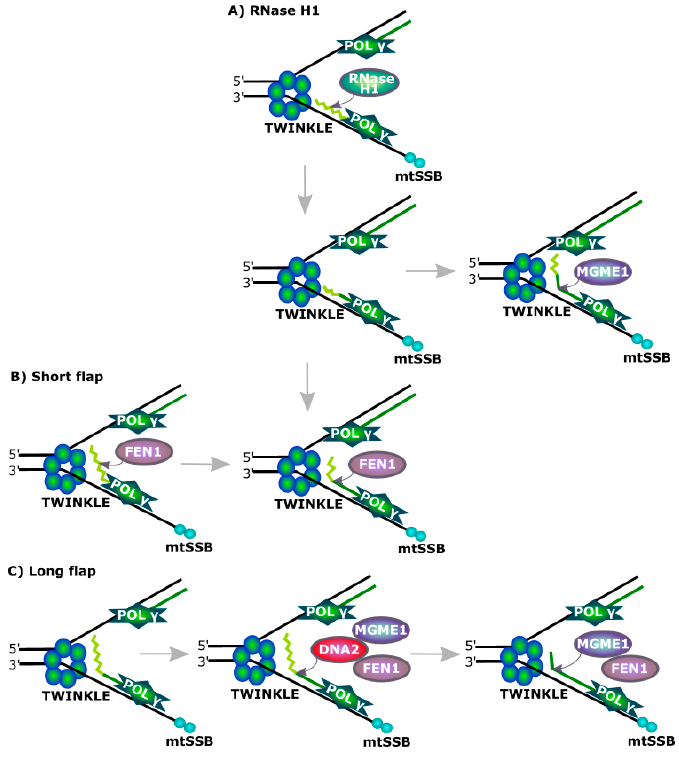
Figure 4. Primer removal during mitochondrial DNA replication. Progress of replication fork is mediated by a DNA topoisomerase (not presented here) separating intertwined mtDNA and the TWINKLE helicase. RNase H1 can degrade most of an RNA primer, but it is not able to remove its last ribonucleotide. When this fragment is reached by Pol γ , it is displaced as a short flap, which can be degraded by FEN1 or MGME1 (mitochondrial genome maintenance exonuclease 1). FEN1 can cleave away entire RNA primer, when it forms a flap and is not too long, but during replication of a heavy strand of mtDNA, primers are much longer than those of its light counterpart and FEN1 cannot do so. In that case, a coordinated action of FEN1 and DNA2 or MGME1 preceded by FEN1 can occur. mtSSB is a mitochondrial single stranded DNA-binding